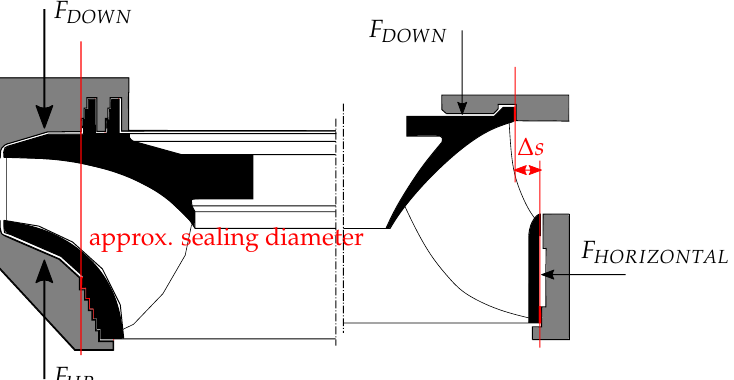
Figure 5. Sealing positions of the investigated runners: pumped storage plant 1 ( left ) and hydropower plant 2 ( right